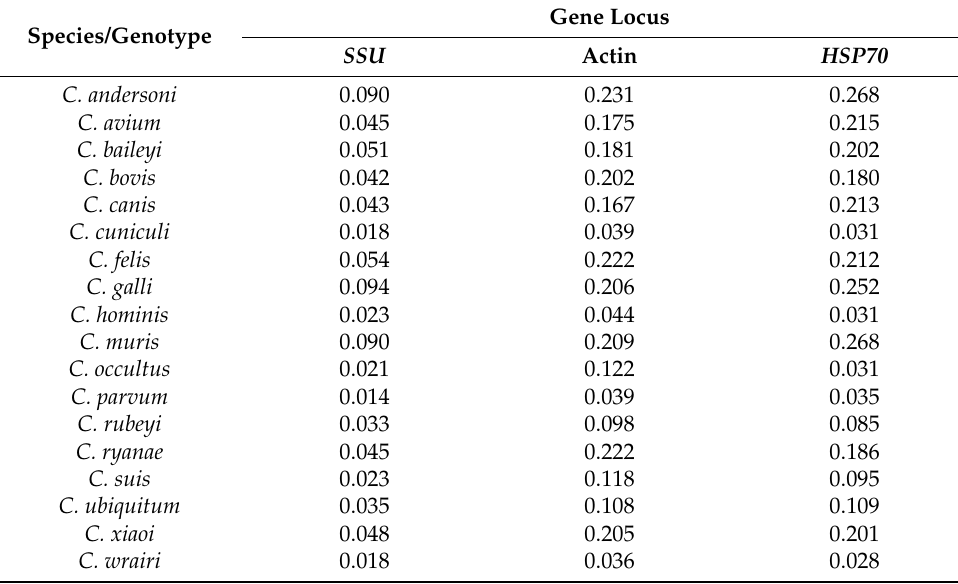
Table A2. Pairwise distances between Cryptosporidium myocastoris n. sp. and selected closest and furthest Cryptosporidium species at small subunit ribosomal RNA ( SSU ), actin, and 70 kDa heat- shock protein ( HSP 70)